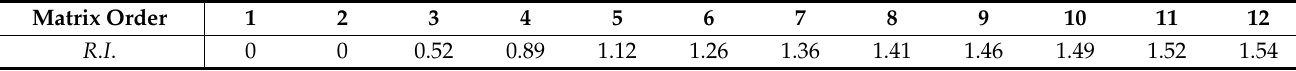
Table 5. Average random consistency index table